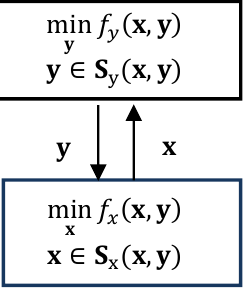
Figure 2. A bi-level hierarchical optimization